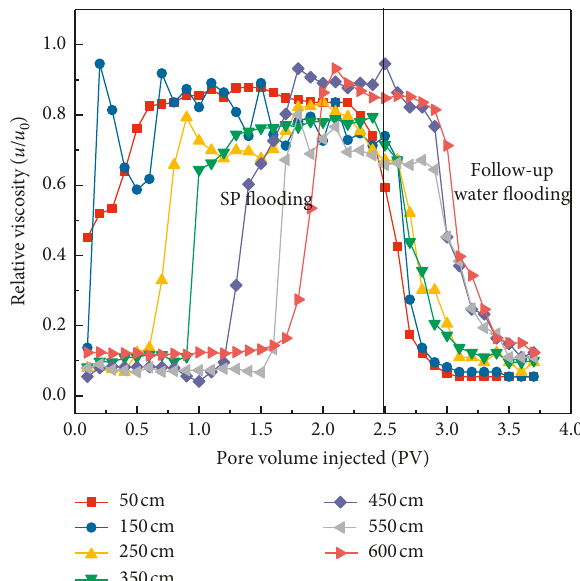
Figure 7: Variation of emulsion viscosity. u is the viscosity of emulsion. u 0 is the viscosity of the surfactant-polymer solution and u 0 � 14mPa ·